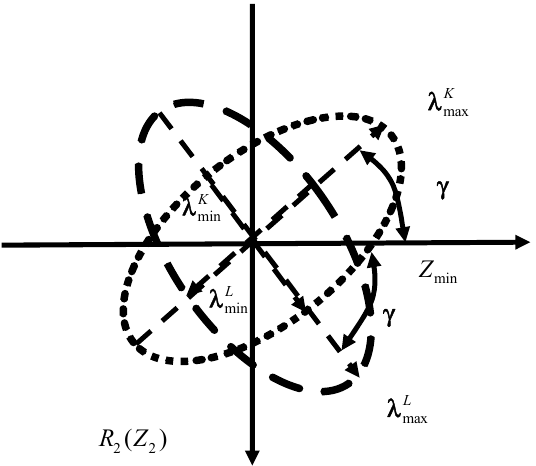
Figure 3. Stiffness ellipse (dots) and flexibility ellipse (dotted line) of an asymmetrical statically indeterminate system.